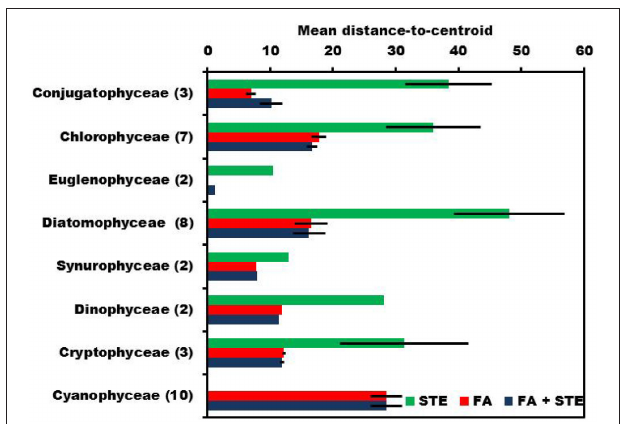
FIGURE 4 | PERMIDISP was used to evaluate dispersion within each phytoplankton class. Highest mean distance-to-centroid was measured when sterols (STE) were used alone, but fatty acids (FA) and combined data of sterols and fatty acids (STE + FA) have similar